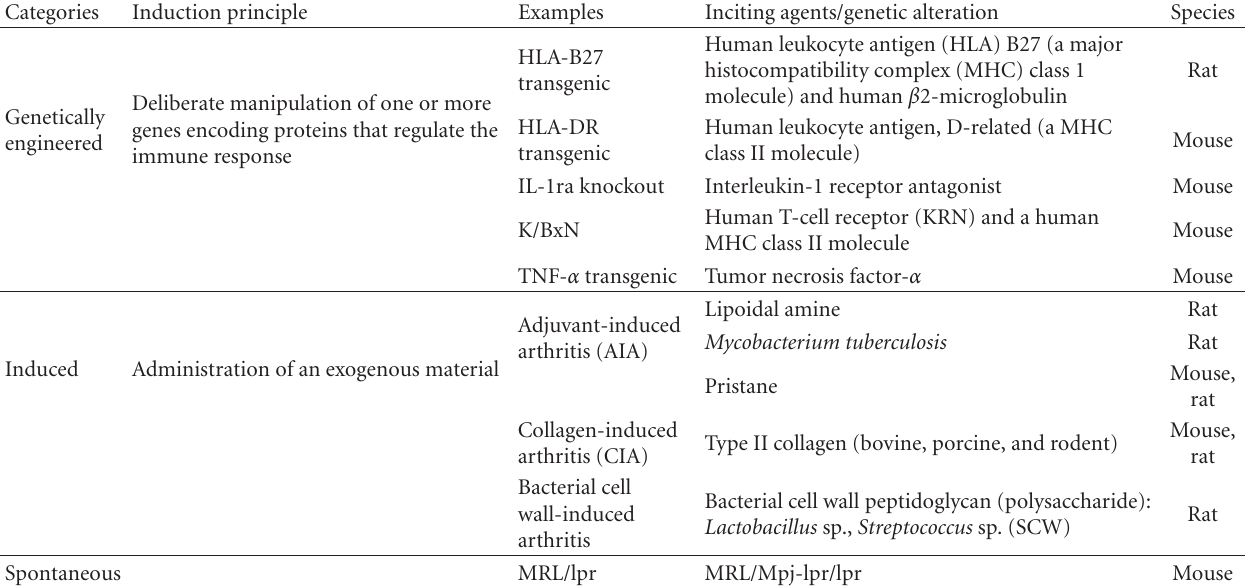
Table 1: Common rodent models of immune-mediated arthritis used in preclinical development of antiarthritic therapies.